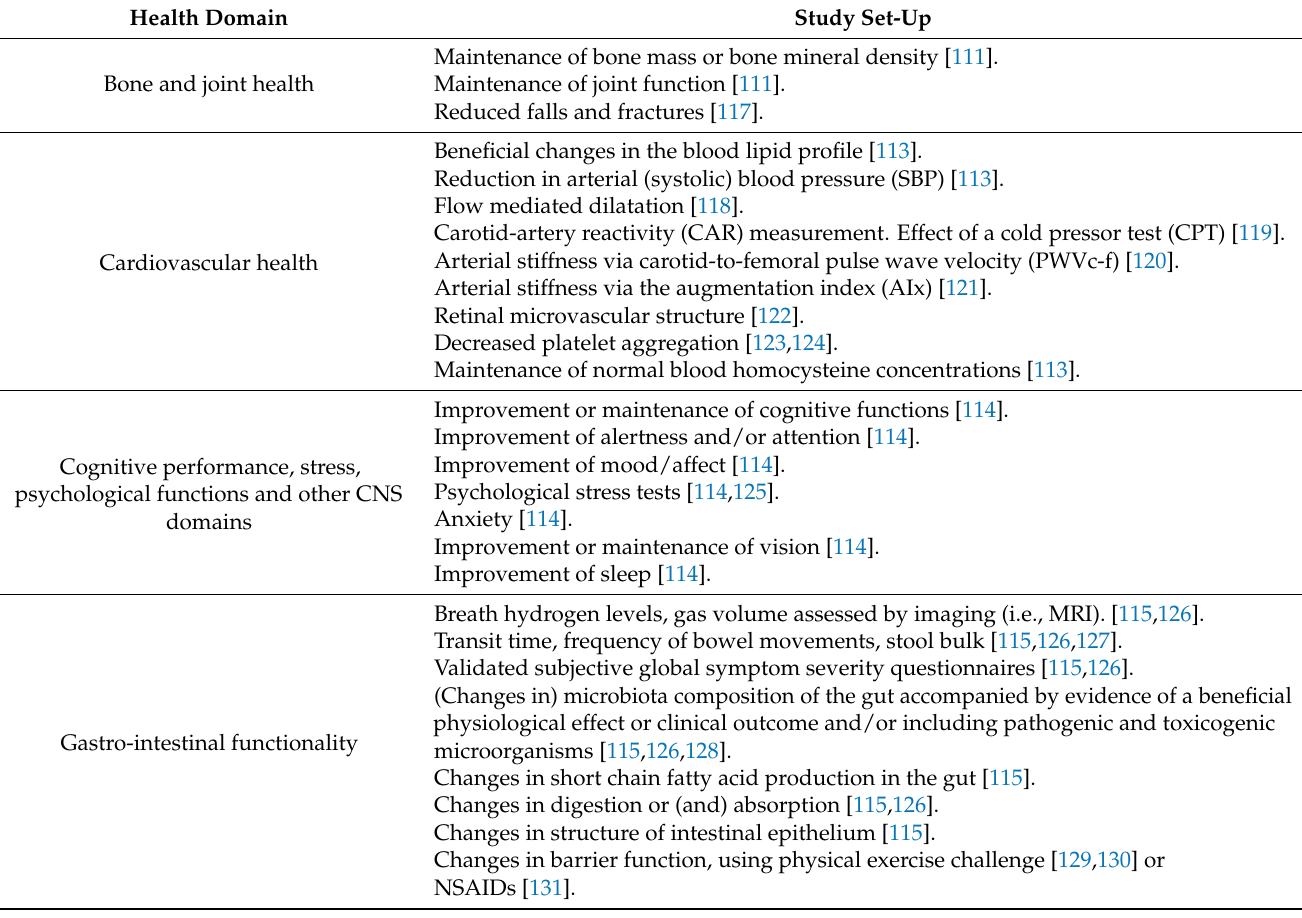
Table 1. Examples of study set-ups as per health domain as taken from the literature, including recent EFSA guidance docu- ments. Health